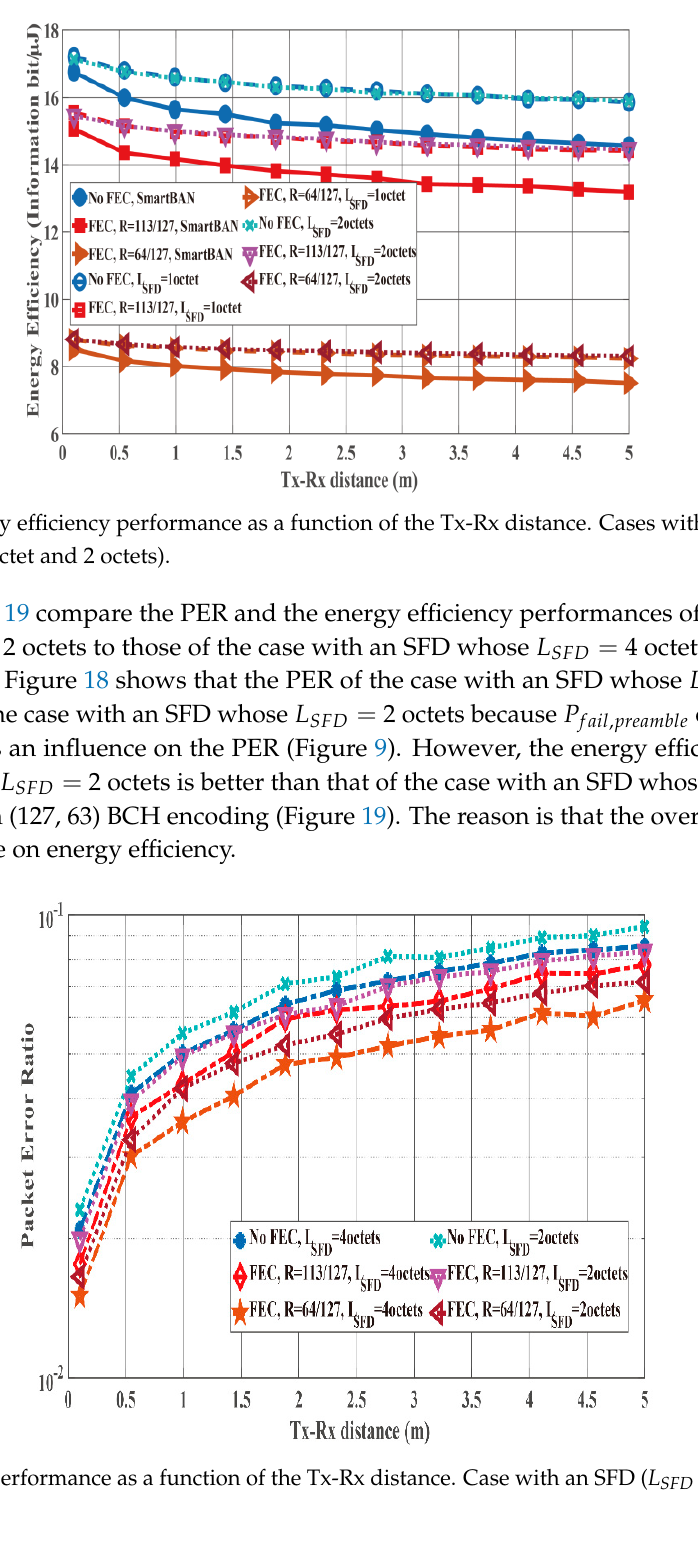
Figure 16. PER performance as a function of the Tx-Rx distance. Cases without and with SFDs ( 𝐿 𝑆𝐹𝐷 = 1 octet and 2 octets).